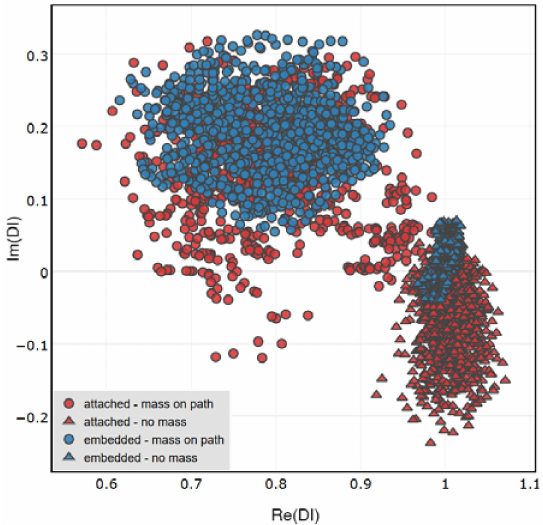
Figure 16. Comparison of DIs obtained for the embedded and surface attached PZT networks under certain measurement